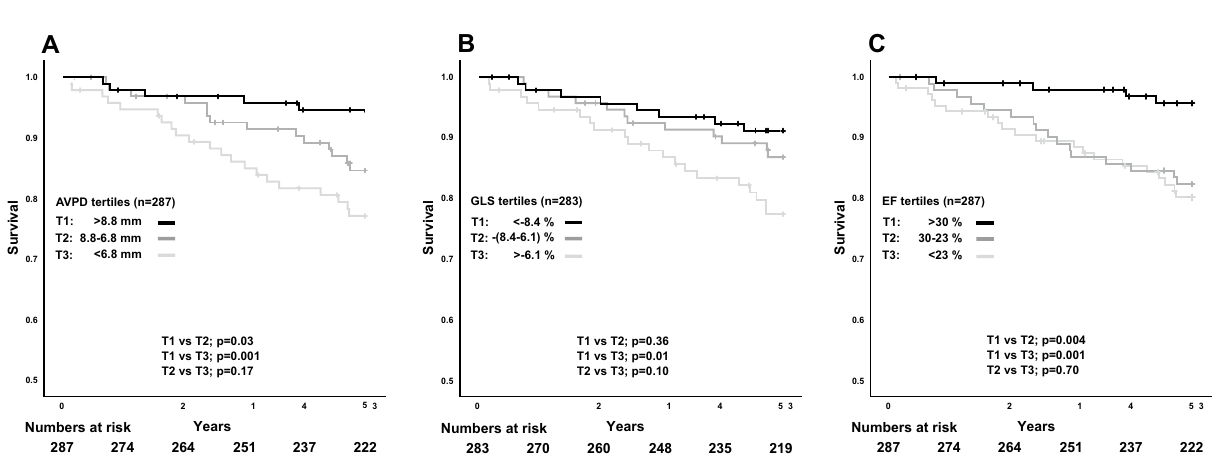
Figure 2. Cardiovascular death. Kaplan–Meier curves showing survival from cardiovascular death stratified by tertiles for ( A ) atrioventricular plane displacement (AVPD), ( B ) global longitudinal strain (GLS) and ( C ) ejection fraction (EF) for the 5-year follow-up in panels. T1 upper tertile, T2 middle tertile, T3 lower tertile.